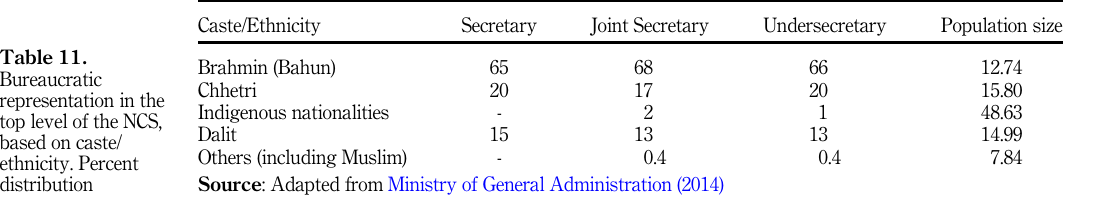
Table 10. Representation of the different ethnic groups in the NCS (higher official levels)